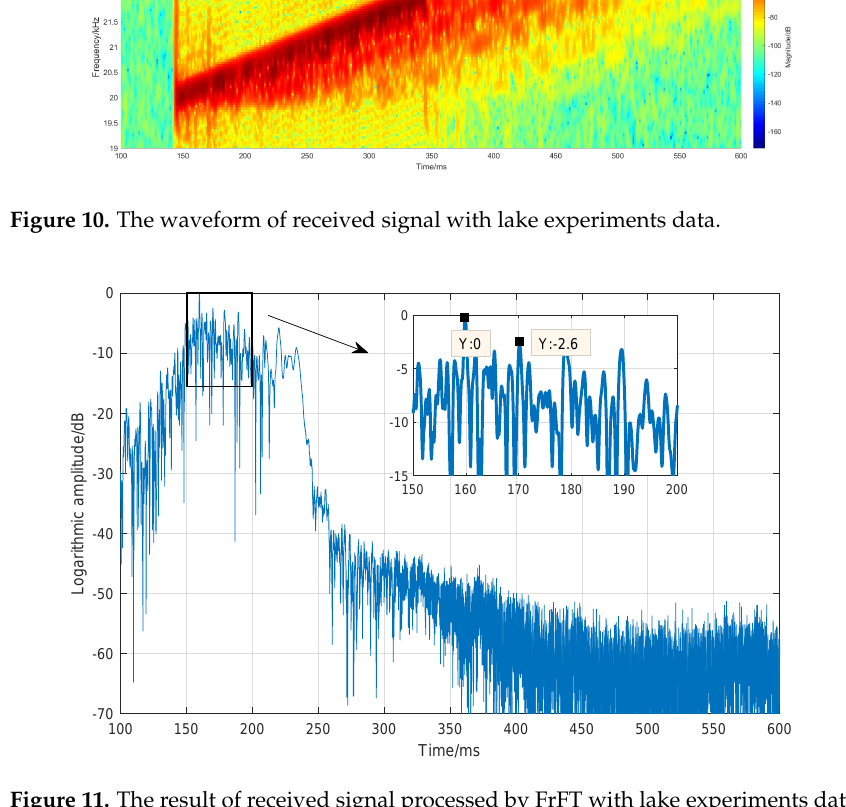
Figure 11. The result of received signal processed by FrFT with lake experiments